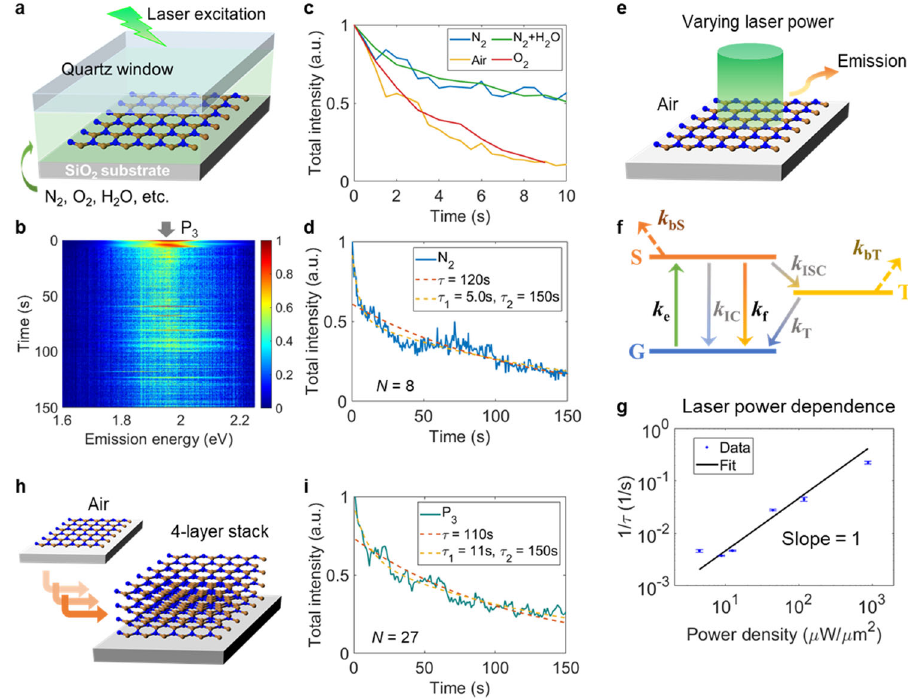
Fig. 3 Bleaching mechanism of P3 emission in monolayer CVD hBN. a Schematic of a custom-built environmental chamber with a quartz observation window, which could be fi lled with different gases. b Time-trace of P 3 emission in monolayer CVD hBN under a N 2 atmosphere. c Initial 10 s of overall decay curves of P 3 emission in monolayer CVD hBN under N 2 (blue line), N 2 with saturated water vapor (green line), air (yellow line) and O 2 (red line). The number of time-traces ( N ) included in each decay curve is 8 (blue, N 2 ), 20 (green, N 2 with saturated water vapor), 31 (yellow, air) and 36 (red, O 2 ), respectively. d Intensity decay curve (blue line) of monolayer CVD hBN under N 2 ( N = 8) is fi tted with a single exponential decay function (red dashed line) and two exponential decay functions (yellow dashed line), where the single-decay- fi t shows larger discrepancy. From the two-exponential fi t with 95% con fi dence interval, we obtain two bleaching lifetimes of τ 1 = 5.0 ± 1.1 s and τ 2 = 150 ± 10 s. e Schematic of laser power dependence measurement, with monolayer CVD hBN on SiO 2 substrate in the air. f Illustration of a three-energy-system with ground singlet state (G), excited singlet state (S) and excited triplet state (T). Photobleaching reactions could occur from both excited states, with microscopic rate constants of k bS and k bT . Rate constants of k e , k k fl uorescent emission and internal conversion, respectively. Additionally, k k f and IC correspond to excitation, ISC and T correspond to intersystem crossing and depopulation from T to G, respectively. g Beaching rate 1/ τ , i.e., the inverse of bleaching lifetime, is linearly dependent on the power density of the incident laser, which could be well explained by the three-energy-system in ( f ). For the three data points in the lower power density range, each is extracted from the sum of ~100 time-traces; and for the other three, each is extracted from the sum of 20 to 30 time-traces. The error bars correspond to 95% con fi dence intervals. h Four-layer stack (right) is constructed by repeatedly transferring monolayer CVD hBN onto the same substrate. i Total intensity of four-layer stack (green line) in the air ( N = 27) is fi tted with a single exponential decay function (red dashed line) and two exponential decay functions (yellow dashed line), where the latter is a better fi t. The two bleaching lifetimes are 11 ± 3.9 s and 150 ± 20 s,